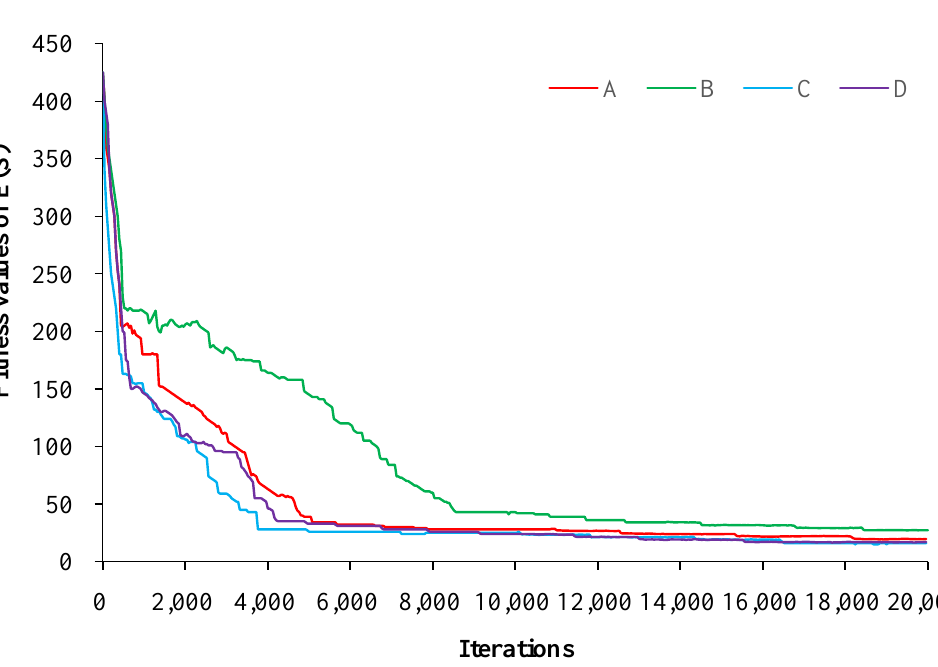
Figure 7. Convergence process of the objective function ( ) E s under different parameter